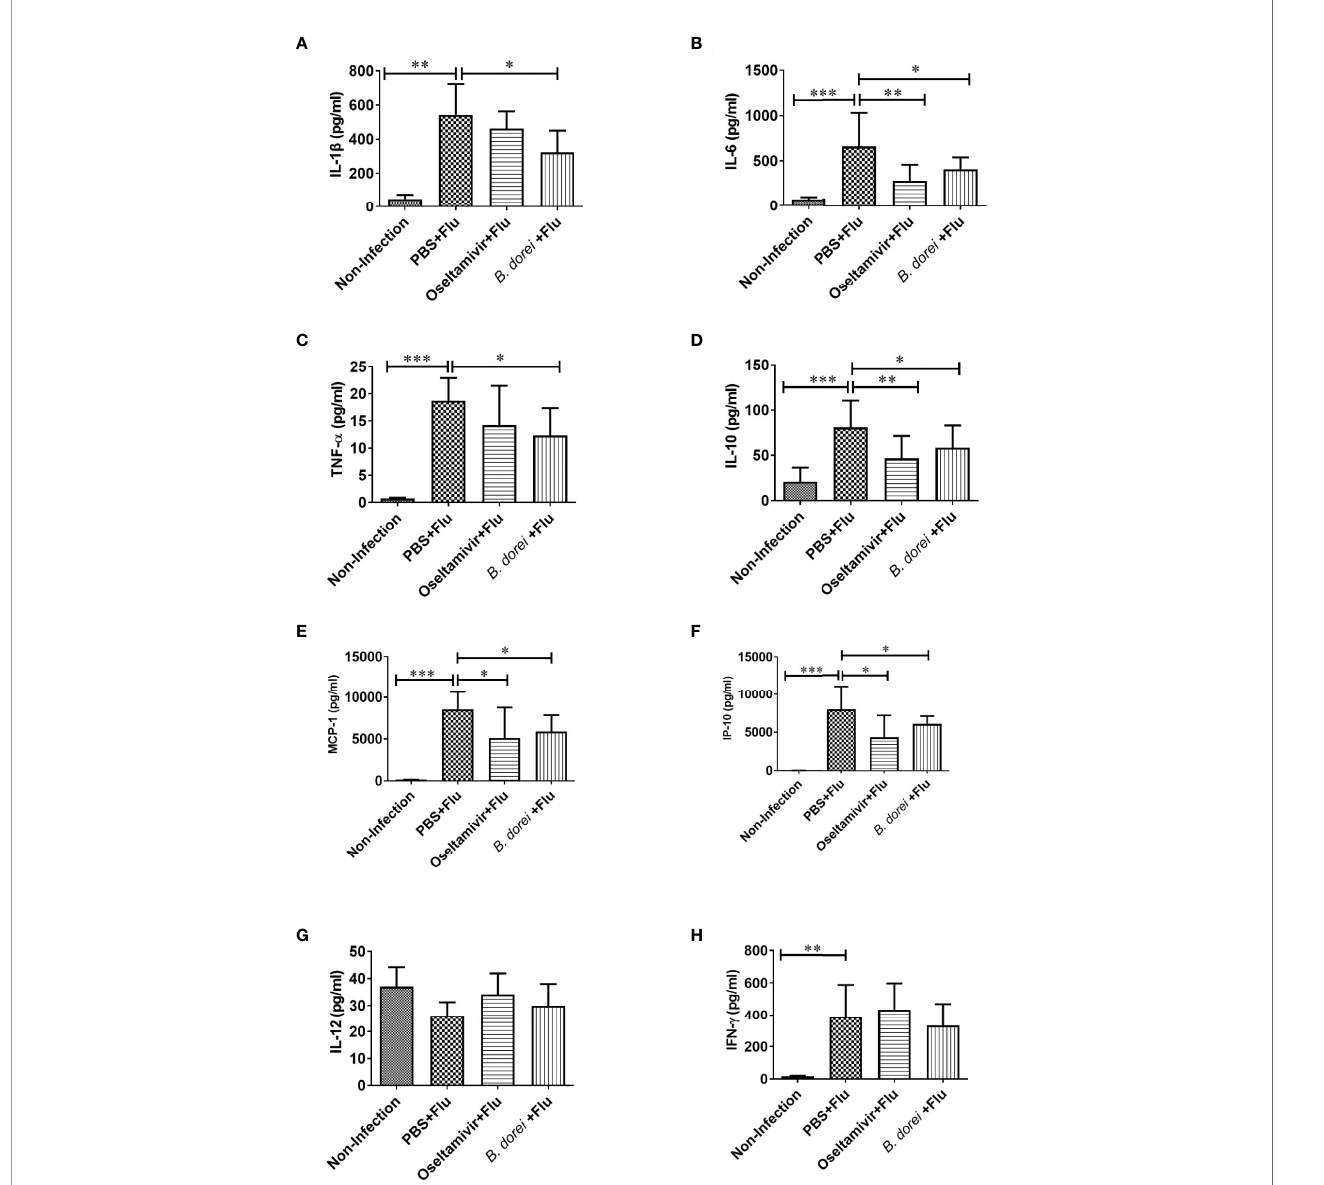
FIGURE 5 | Effects of B.dorei on lung cytokine pro fi les at day 7 post infection. The levels of cytokines and chemokines in lung tissue of the Non-Infection group, the PBS+Flu group, the B. dorei +Flu group and the oseltamivir+Flu group were compared and showed as follows: IL-1 b (A) , IL-6 (B) , TNF- a (C) , IL-10 (D) , MCP-1 (E) , IP-10 (F) , IL-12 (G) and IFN- g (H) . The data in panels (A – H) are shown as mean ± standard deviation from three independent experiments. *p < 0.05, **p < 0.01, ***p <